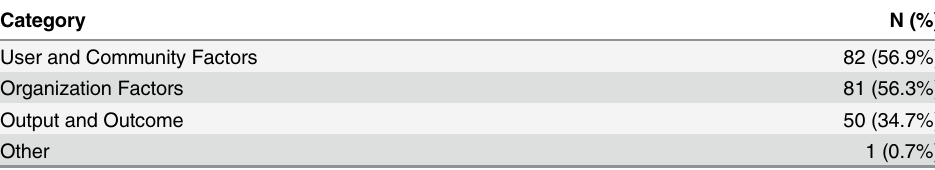
Table 1. Distribution of studies according to